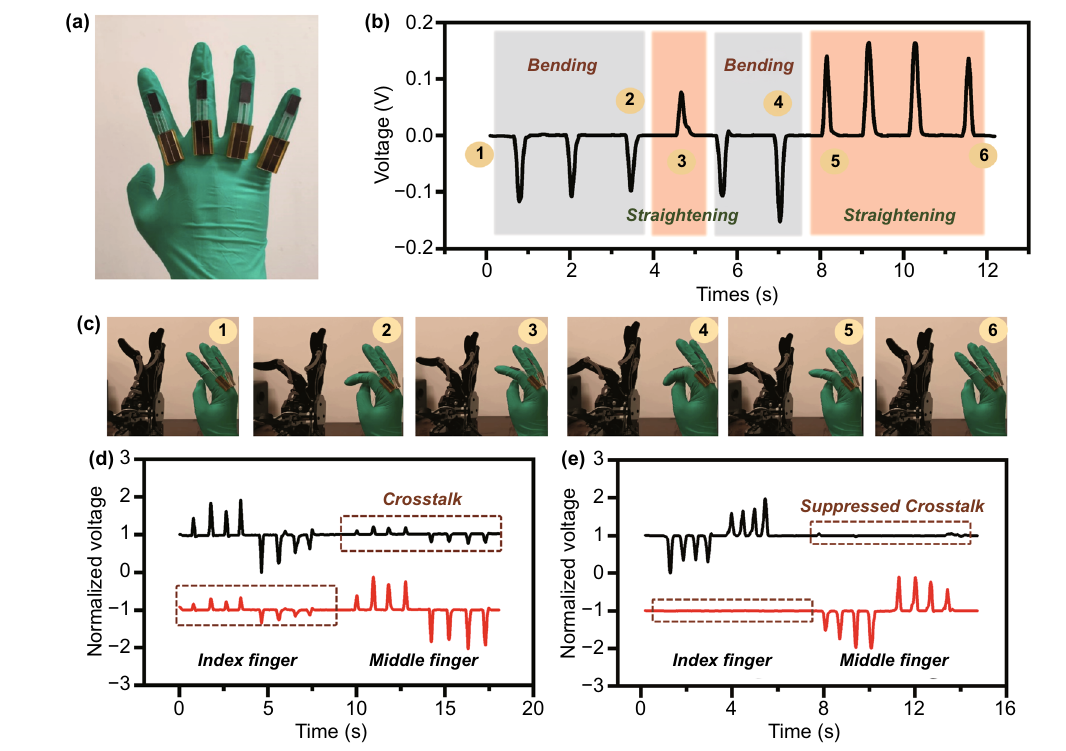
Fig. 5 Real-time gesture interaction demonstration. a Ma-s-TS worn on the fingers. b Positive and negative pulses represent straightening and bending of finger. c Real-time gesture interaction of robotic hand and human hand based on the signal of Fig. 5b. d–e Comparison with jmTQS [15] on cross talk between channels ( d jmTQS, e